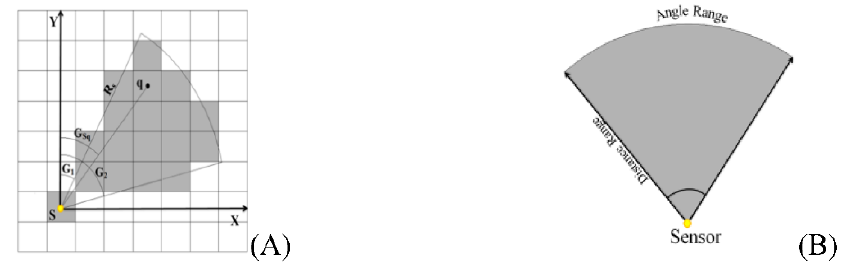
Figure 2. Estimation of two-dimensional coverage: ( A ) raster model (gray pixels are covered by the sensor S); and ( B ) vector model (gray part is in the sensor S coverage zone) [32].